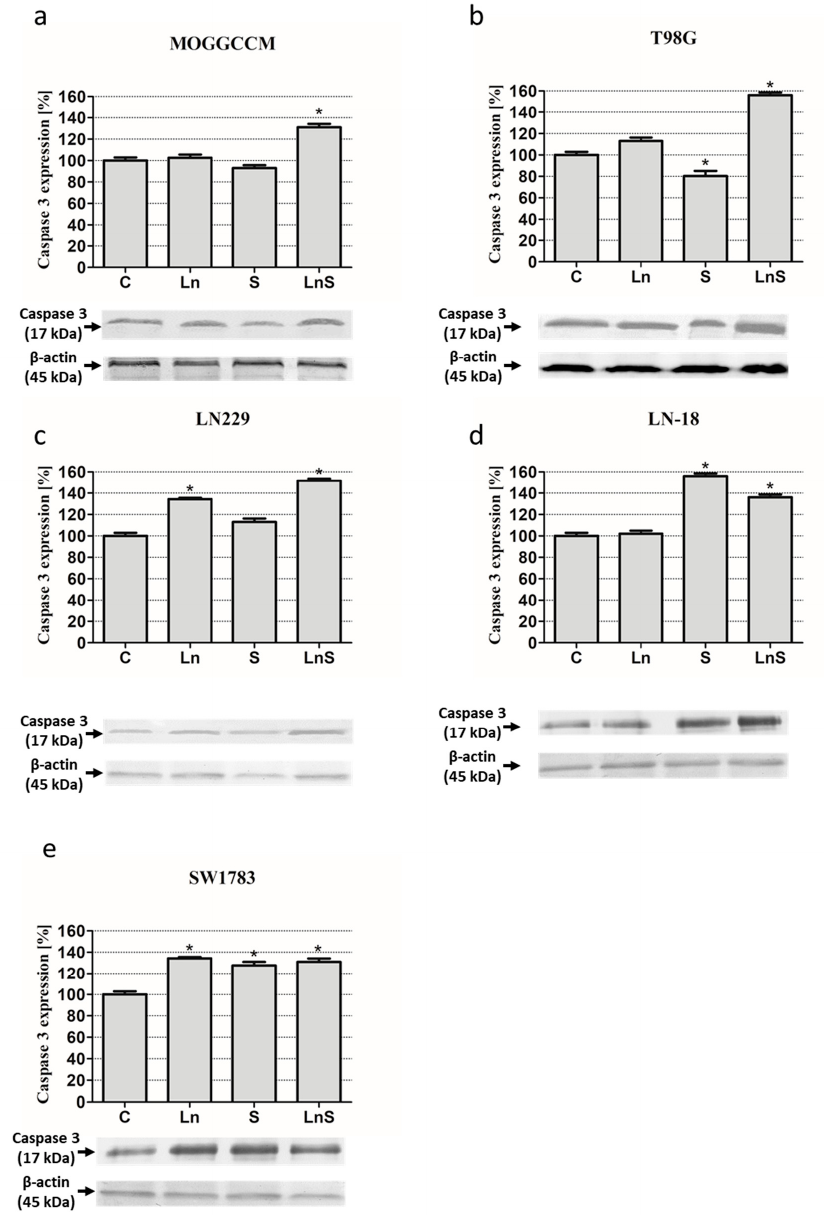
Figure 6. Level of active caspase 3 with representative blots in MOGGCCM ( a ), T98G ( b ), LN229 ( c ), LN-18 ( d ), and SW1783 ( e ) cells after treatment with lensoside A β (L) and sorafenib (S) applied alone or in combination (LS). C—control; * p < 0.01 compared to the control.